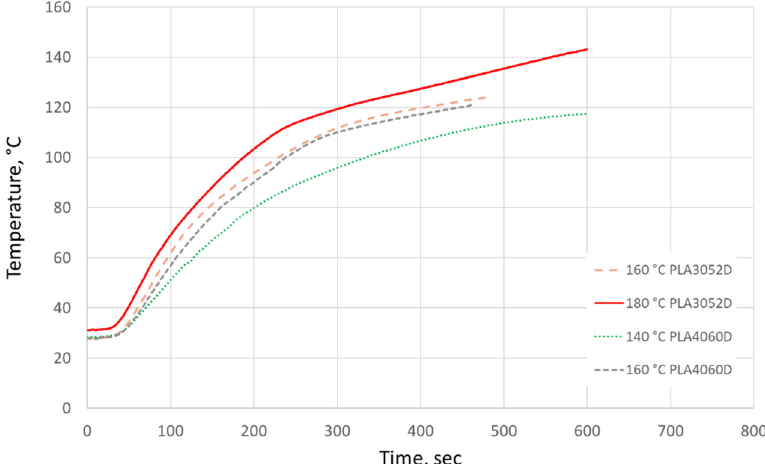
Figure 1. Selected internal panel temperature profiles for 5-ply panels formed at differing pressing temperatures (140 °C, 160 °C and 180 °C) with either semi-crystalline (3052D, purple and red) and amorphous (4060D, blue and green) PLA.